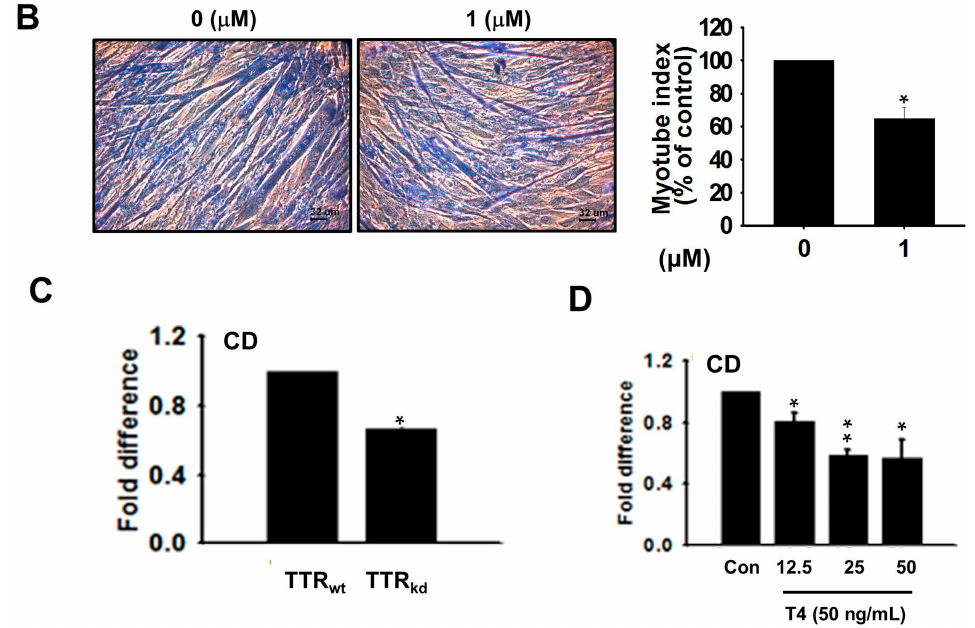
Figure 5. Effect of coumarin derivative (CD) on T4 to TTR binding. C2C12 cells grown in DMEM supplemented with 10% or 2% FBS were washed and incubated in serum-free media for 12 h. ( A ) Pictures showing fluorescence attributed to CD to TTR binding in C2C12 cells during growth in proliferation and differentiation media; ( B ) Giemsa staining showing myotube differences between C2C12 cells grown in differentiation media with or without CD (1 µ M); ( C ) Graph showing CD intensity as fold differences in TTR wt and TTR kd cells; ( D ) CD intensity was measured in serum free media containing different concentrations of T4. p -Values indicate statistical significance (mean ± S.D., n = 3, *: p < 0.05, **: p < 0.001).